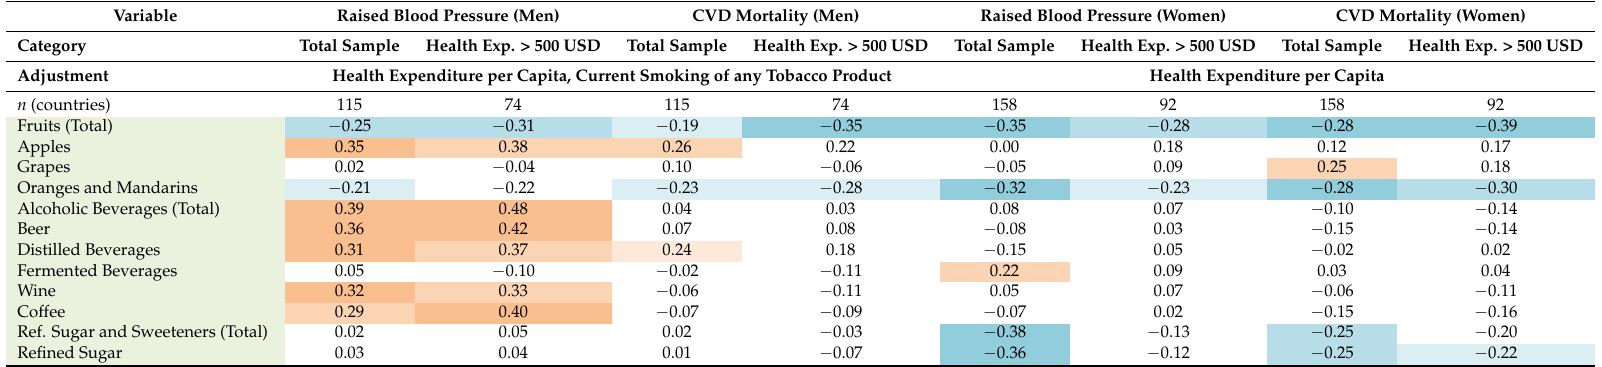
Table 6. Partial correlations of raised blood pressure and CVD mortality with nutritional factors, adjusted for smoking and health expenditure per capita.